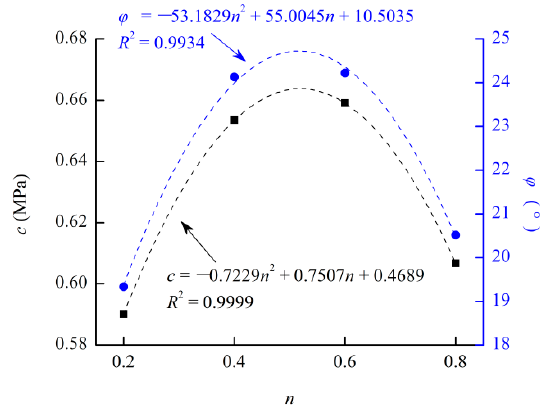
Figure 11. Relationship between the fitting strength parameter and Talbot index of CPB specimens.